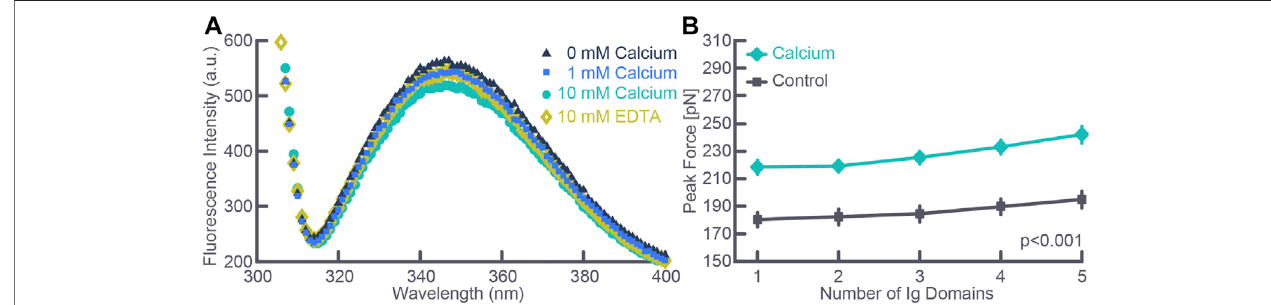
FIGURE 3 | (A) Fluorescence intensity measured using spectroscopy as a function ofcalcium concentration for an exemplar test. Note the depression of the peak intensity fl uorescence with increasing calcium concentration and the reversal of the peak fl uorescence intensity when removing free calcium using EDTA. (B) Force required to cause unfolding of fi ve immunoglobulin domains in the absence (Control) and the presence (Calcium) of physiologically relevant calcium concentration. Note that the force required for immunoglobulin unfolding increased by about 20% in the presence of calcium. Note also, the slight increase in force required with each unfoldingeventdespite identical immunoglobulindomains which isexplainedbythestochasticnature oftheunfolding events. Thetotal number ofobservations foreach data point was greater than 300 in all cases, and data points where the standard deviation bars cannot be seen indicates that the standard deviations were smallerthan the size of the data point. Republished with permission of American Physiological Society, from Passive force enhancement in striated muscle. Herzog W. Journal of Applied Physiology 126 (6): 1782 – 1789. 2019; permission conveyed through Copyright Clearance Center Inc.